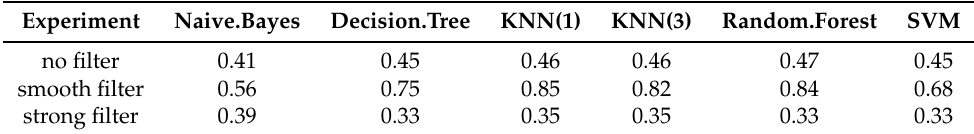
Table 5. Accuracy mean of the 3 3 validation datasets. Experiment